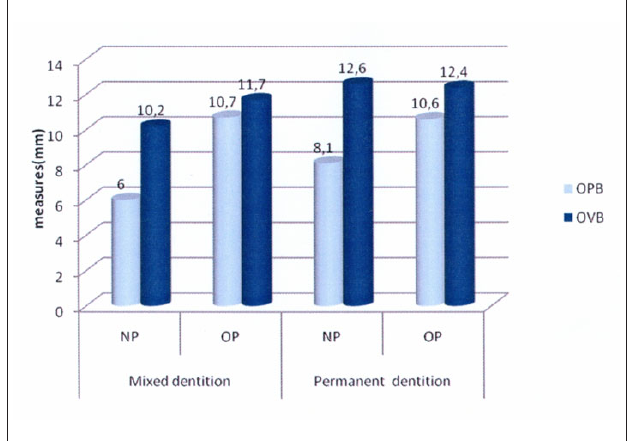
Fig. 1 . Mean NP and OP values for overbite and open bite groups regarding mixed and permanent dentitions. Footnote: NF- nasopharynge. OF- oropharynge. OPB- open bite. OVB-